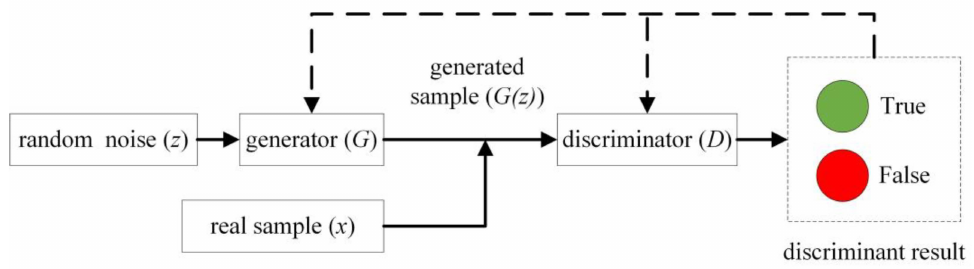
Figure 1. Flow chart of the GAN